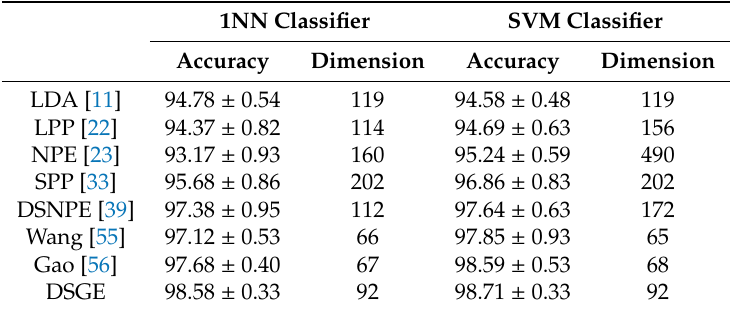
Table 3. Experimental results with the mixed interference factors on the AR database.